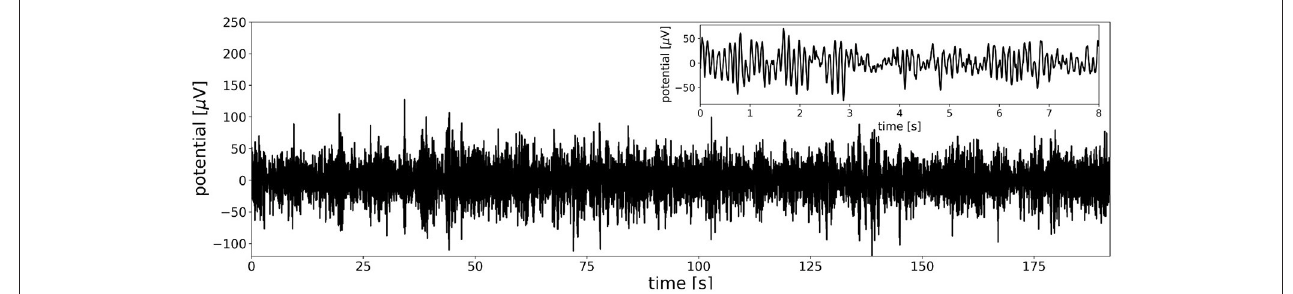
FIGURE 2 | The overall structure of the EEG time series is visualized by the first principal component of the data set. The first principal component of the test file yields a time series similar to the signals observed at single electrodes, especially at parietal and occipital locations. The main feature of the data set are amplitude modulated oscillations in the alpha frequency band (8–12 Hz). The inset in the upper right corner shows the first 8 s of data to better visualize the characteristic alpha oscillations at a shorter time scale.